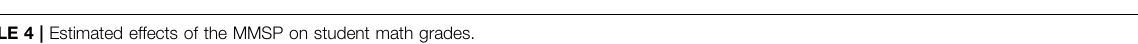
TABLE 4 | Estimated effects of the MMSP on student math grades.